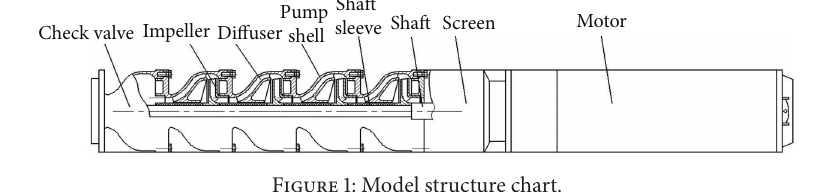
Figure 1: Model structure chart. Table 1: Data structure of the multi-target orthogonal